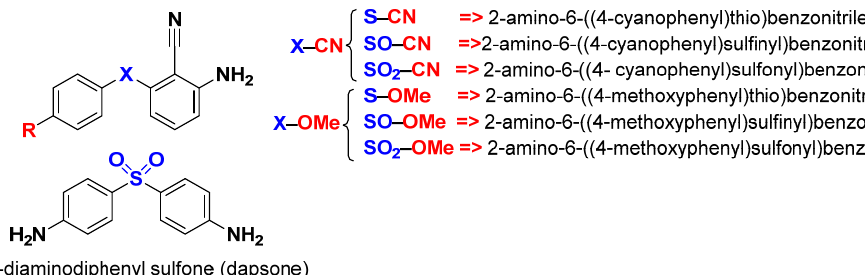
Figure 1. Chemical structures of investigated compounds with their IUPAC names as well as nicknames. The common molecular structure of the seven compounds is diphenyl sulfide.